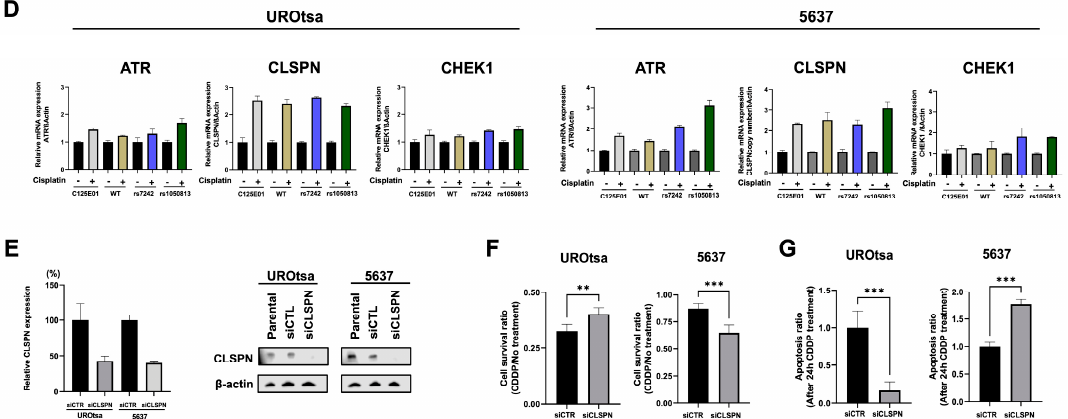
Figure 3. PAI1 rs7242 is involved in the resistance to apoptosis induced by cisplatin. ( A ) Protein and mRNA expression of PAI1 clones in stable transfectants in UROtsa and 5637 cell lines. ( B ) Apoptosis assays using RealTime-Glo™ Annexin V Apoptosis and Caspase-Glo ® 3/7 Assays. ( C ) Profiling the expression of multiple proteins associated with apoptosis induced by cisplatin using a membrane-based sandwich immunoassay. ( D ) mRNA expression levels of ATR-CLSPN-CHEK1 pathway. ( E ) Silencing CLSPN by siRNA in parental UROtsa and 5637 cell lines. ( F ) Cell survival assay after cisplatin treatment. ( G ) Apoptosis assay after cisplatin treatment. Bars represent SE. ** p < 0.01; *** p < 0.001, **** p < 0.0001.